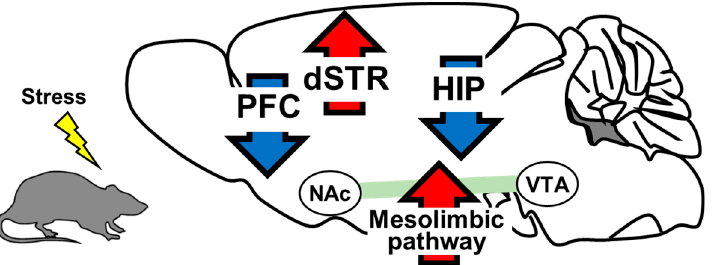
Figure 1. BDNF levels in rodent model of depression. BDNF expression in the PFC and hippocampus was decreased in the RSDS-induced depression model mice. BDNF in the PFC and hippocampus has an anti-depressant effect. BDNF expression in the NAc and dorsal striatum (dSTR) increased in a repeat social-defeat stress (RSDS)-induced depression mouse model. BDNF in the NAc and dorsal striatum shows a pro-depressant effect. Red arrows: upregulation of BDNF levels. Blue arrows: downregulation of BDNF levels. Table 1. List of studies on depression that investigated BDNF mRNA and/or protein function in the brain. Brain region